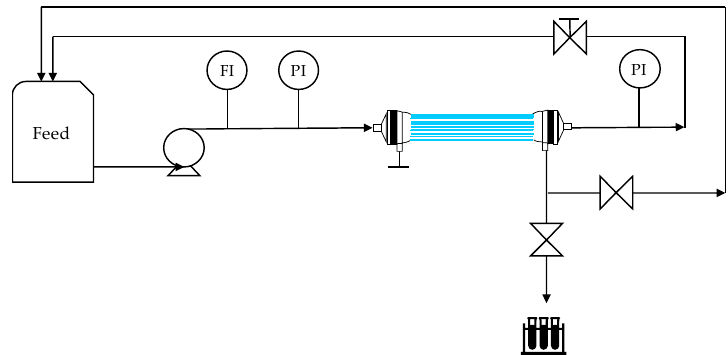
Figure 2. Schematic description of the LPRO setup. Flow meter (FI) and pressure meters (PI).